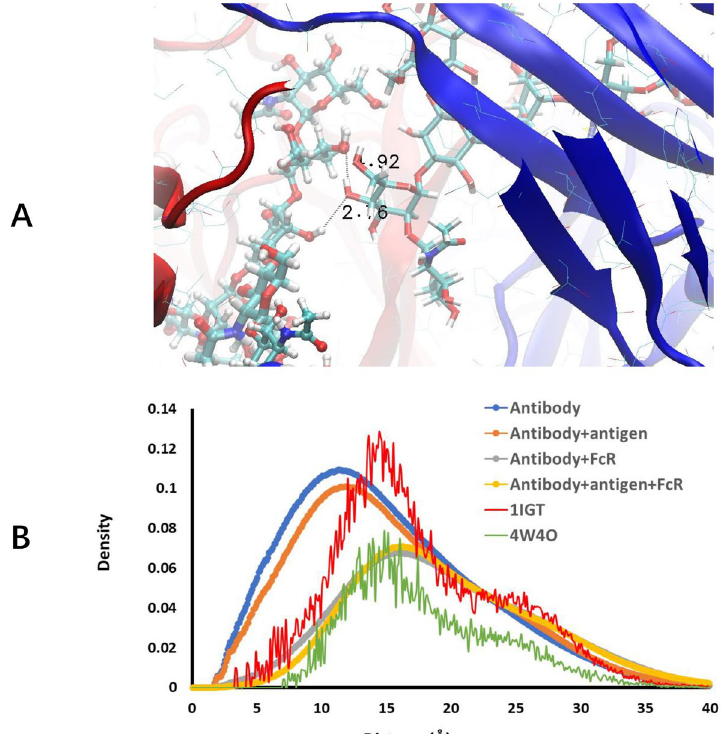
Figure 3. Free antibody has strong but non-specific hydrogen bonds between two carbohydrate chains. (A) Illustration of hydrogen bonds between two carbohydrate residues; (B) radial distance distribution between atoms in two carbohydrate chains in free antibody, antibody-antigen complex, antibody-hFcγRI complex, antibody-antigen-hFcγRI complex, and two crystal structures (1IGT and